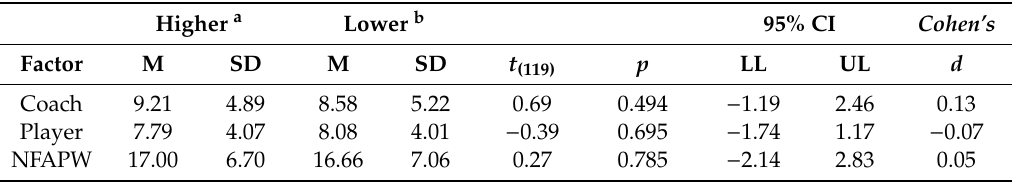
Table 6. NFAPW, coach dimension, and player dimension scores according to